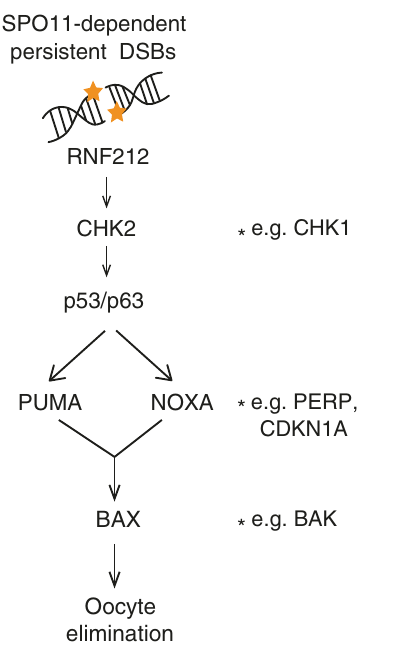
Fig. 5 Role of PUMA NOXA and BAX in the oocyte DNA-damage checkpoint. Asterisks represent additional checkpoint effectors that may contribute to the